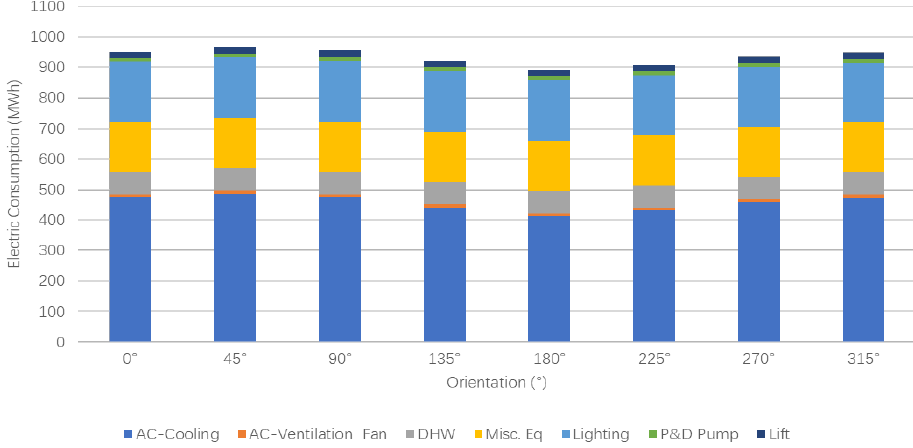
Figure 10. Annual energy consumption for Model 1 in different orientations.